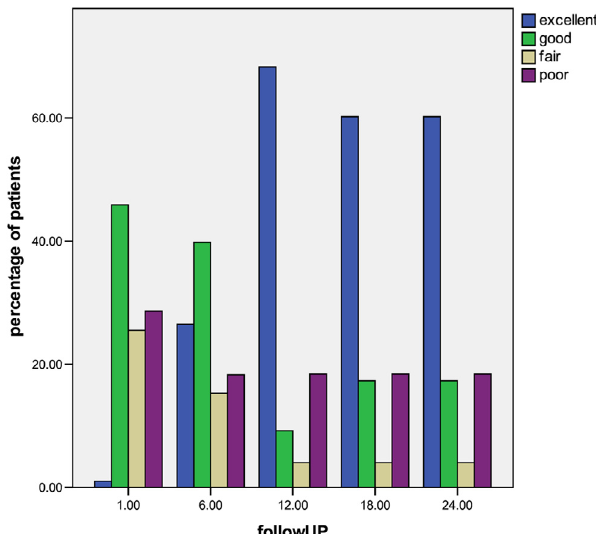
Figure 2. During the first 12 months of the follow-up period the percentage of patients with (excellent) and (good) outcome increased reaching maximum at 12 months follow-up, whereas the percentage of patients with (fair) and (poor) outcome decreased and then remained stable until the end of